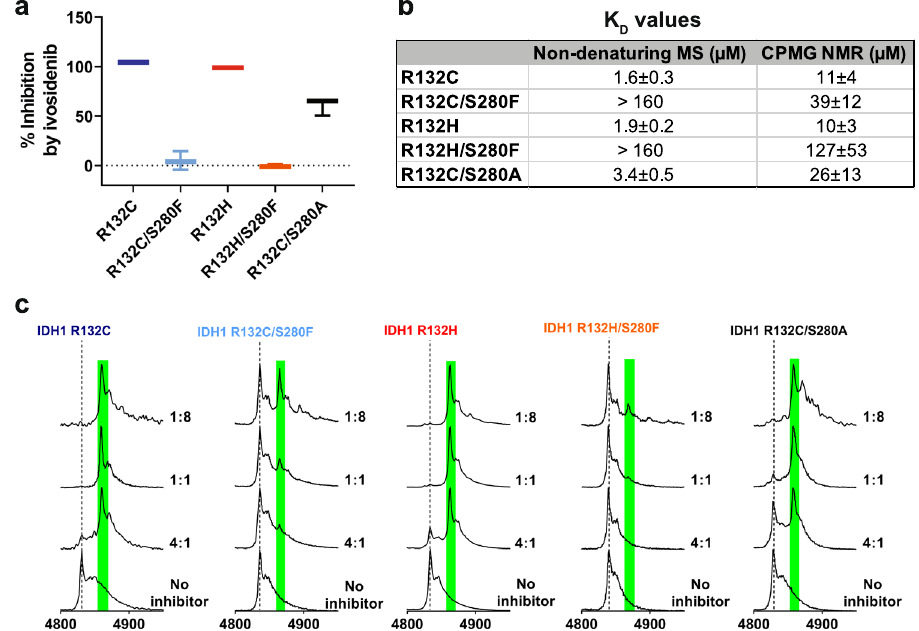
Fig. 2 | The S280F substitution reduces ivosidenib inhibition and binding. a Inhibition (%) of IDH1 variants (400nM) by ivosidenib (10 µ M) as determined by the NADPH absorbance assay. Errors: standard errors of the mean ( n =3 indepen- dentreplicatesmeasuredonthesame96-wellplate).Sourcedataareprovidedasa SourceData fi le. b K D sdeterminedbynon-denaturingMS(20 µ Menzyme,technical errors: n =3 for the z =19, 20, 21 charge states) and using the CPMG Project pulse NMR sequence (10 µ M enzyme, n =2). Non-denaturing MS: ammonium citrate